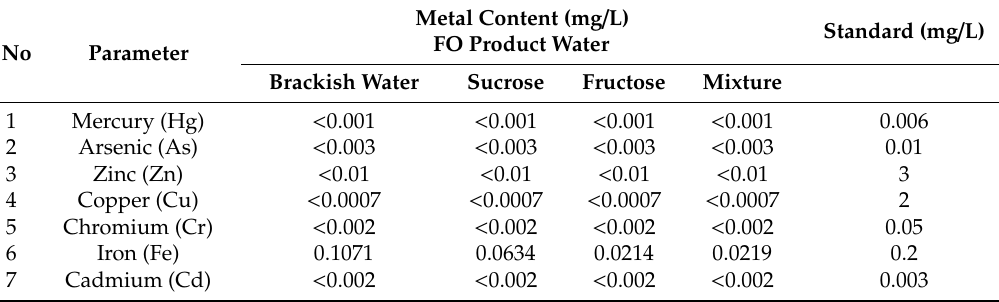
Table 2. The results of the analysis of heavy metal contents in brackish water and FO-processed